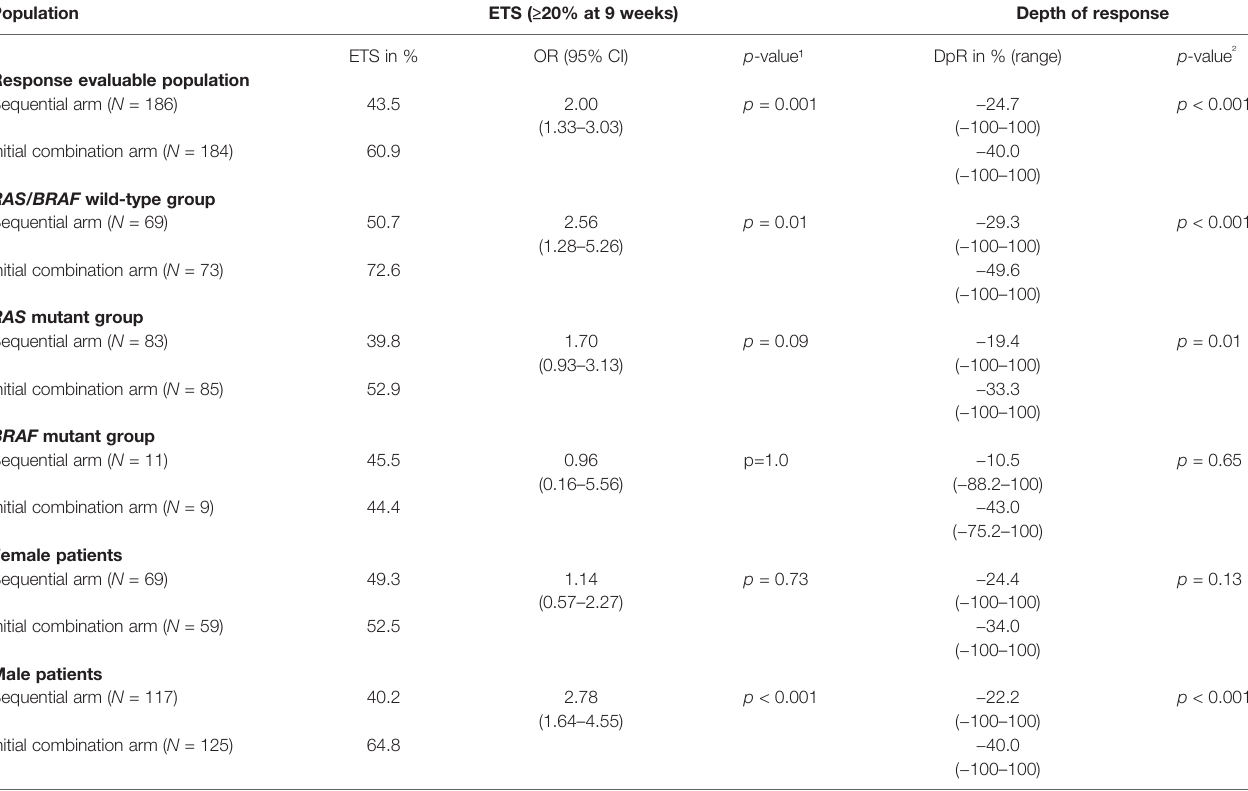
TABLE 2 | Parameters of early treatment response in therapy arms according to tumor mutational status and sex.